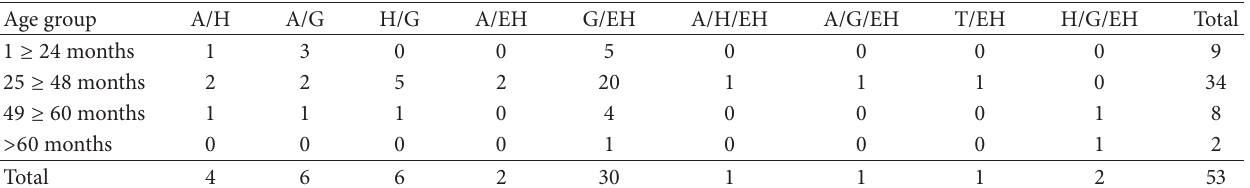
Table 3: Mixed infections of specific soil-transmitted helminths and pathogenic protozoa in each age group.